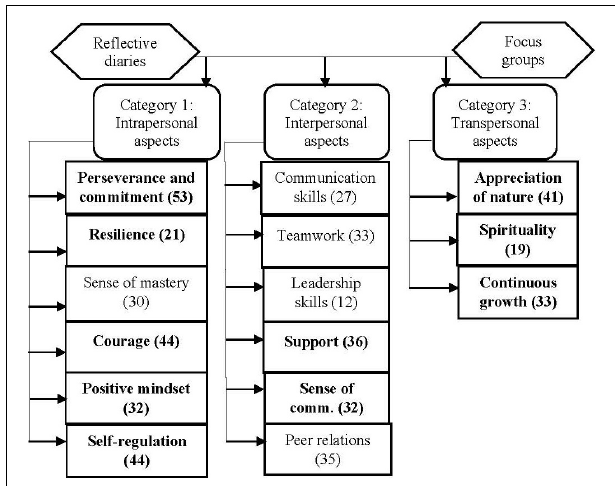
FIGURE 1 | Themes identified regarding peer helpers’ experience of participation in adventure-based experiential learning